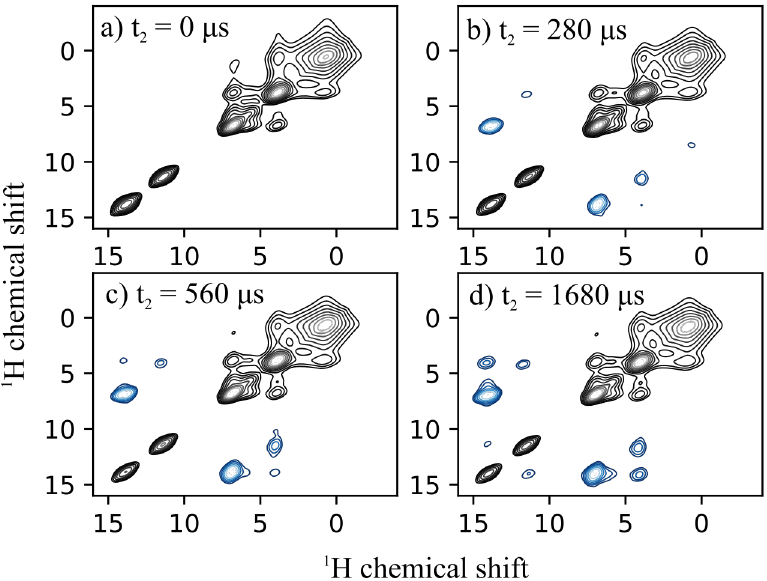
Figure 6. 1 H - 1 H correlation spectra with SERP recoupling using the pulse sequence shown in Figure 2 on ABZ II with t 2 of: ( a ) 0; ( b ) 280; ( c ) 560; and ( d ) 1680 µ s for a τ mix of 2.8 ms. The negative contours (blue) are the double-quantum recoupling peaks between H1 and aromatic protons (H6). The base contour levels are plotted at 20 σ and 2 σ from noise levels for the positive and negative peaks, respectively, and are spaced by a factor of 1.414. The spectra were recorded at a field of 11.7 T with the MAS spinning of 57.143 kHz at a temperature of 320